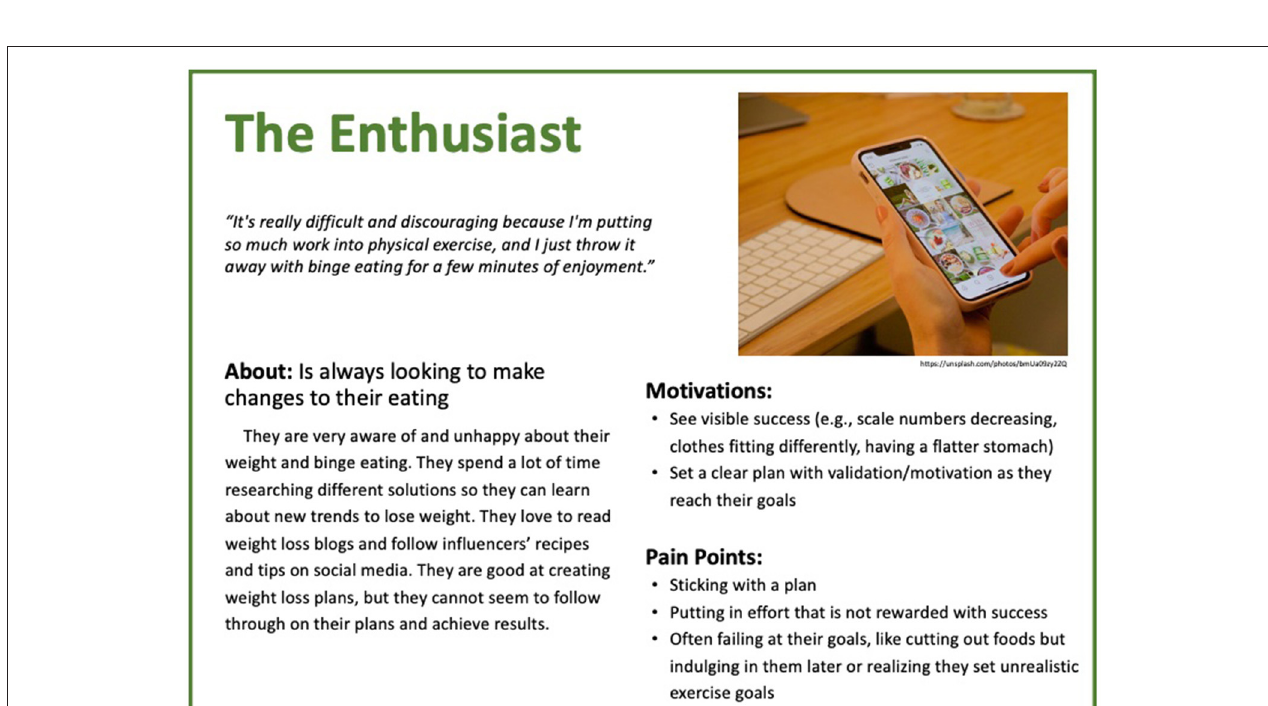
FIGURE 4 | Persona 4: The